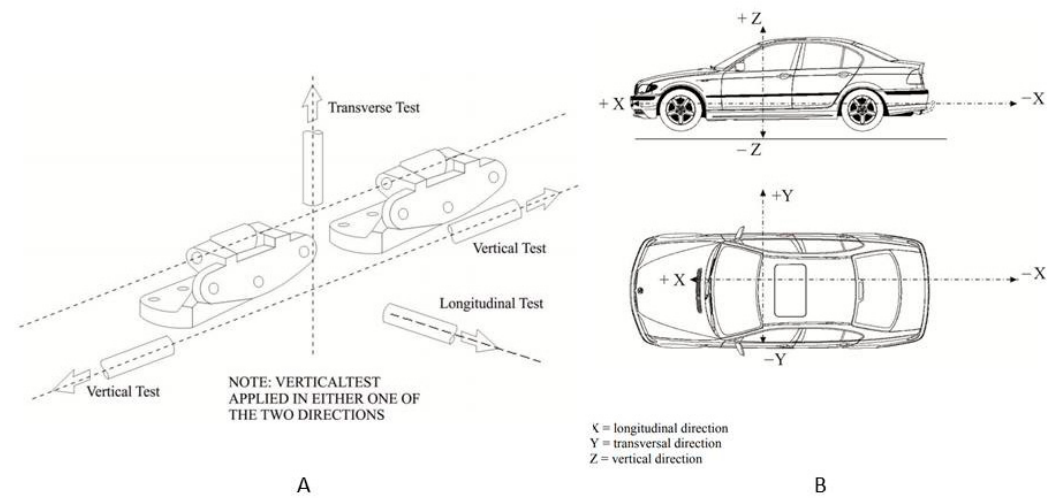
Figure 2. Loading directions of United Nations Economic Commission for Europe (UNECE) R11 (( A ) loading directions according to vehicle coordinate system on door hinge, ( B ) loading directions according to vehicle coordinate system).